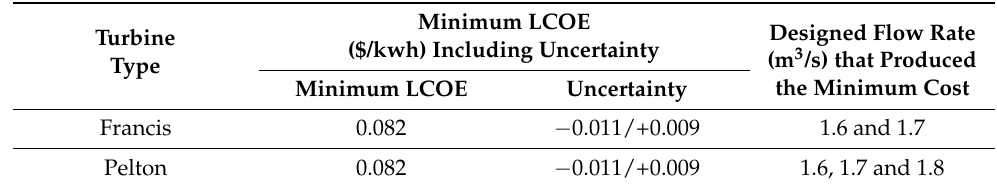
Table 1. The Francis and Pelton minimum LCOE and range of the equivalent minimum LCOE including uncertainty at a net head of 70 m.